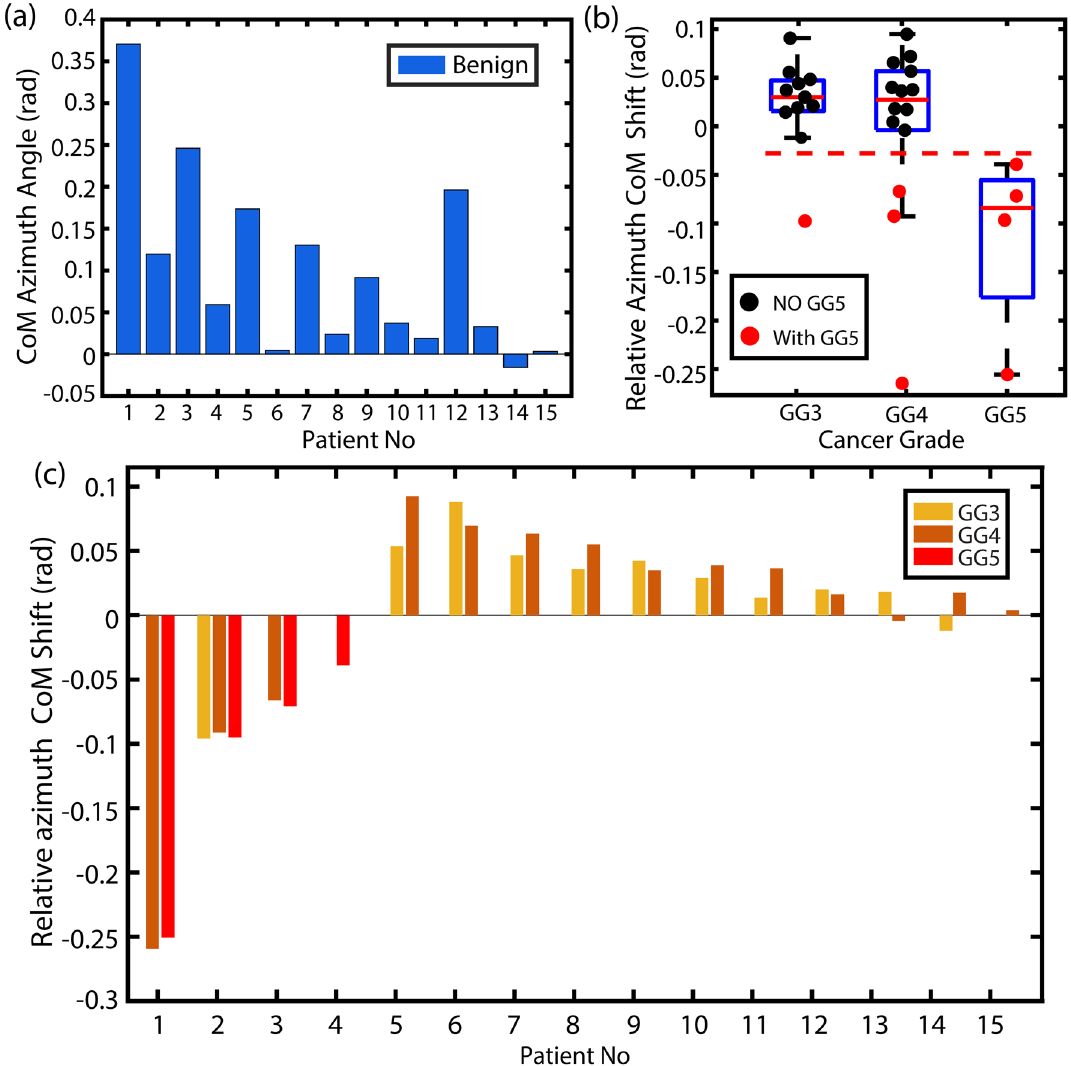
Figure 5. Absolute and relative CoM azimuthal angles serves as a personalized malignancy biomarker and reveal unique glandular phenotypes. ( a ) Comparison of absolute maximum peak azimuthal coordinates of integrated histograms of benign regions for 15 patients. ( b ) Cumulative boxplots for calculated relative azimuthal shift for different prostate cancer grades in 15 patients. ( c ) Barplots for calculated relative azimuthal shift for different prostate cancer grades in 15 patients with the benign region used as reference for each patient. In ( b and c ) it is clear that the more aggressive phenotypes have an opposite shift even for lower grades of cancer. In ( b ) the red dotted line is the threshold of the shift for the more aggressive cancer regions on the opposite